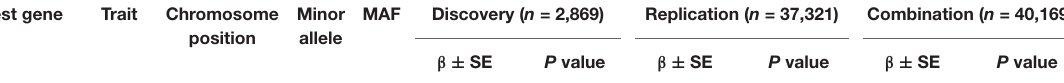
Minor MAF Discovery ( n = position allele